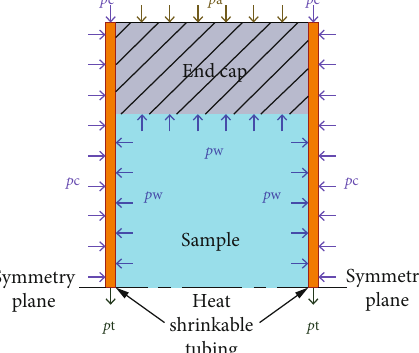
Figure 6: Mechanical model of the water sample under stable